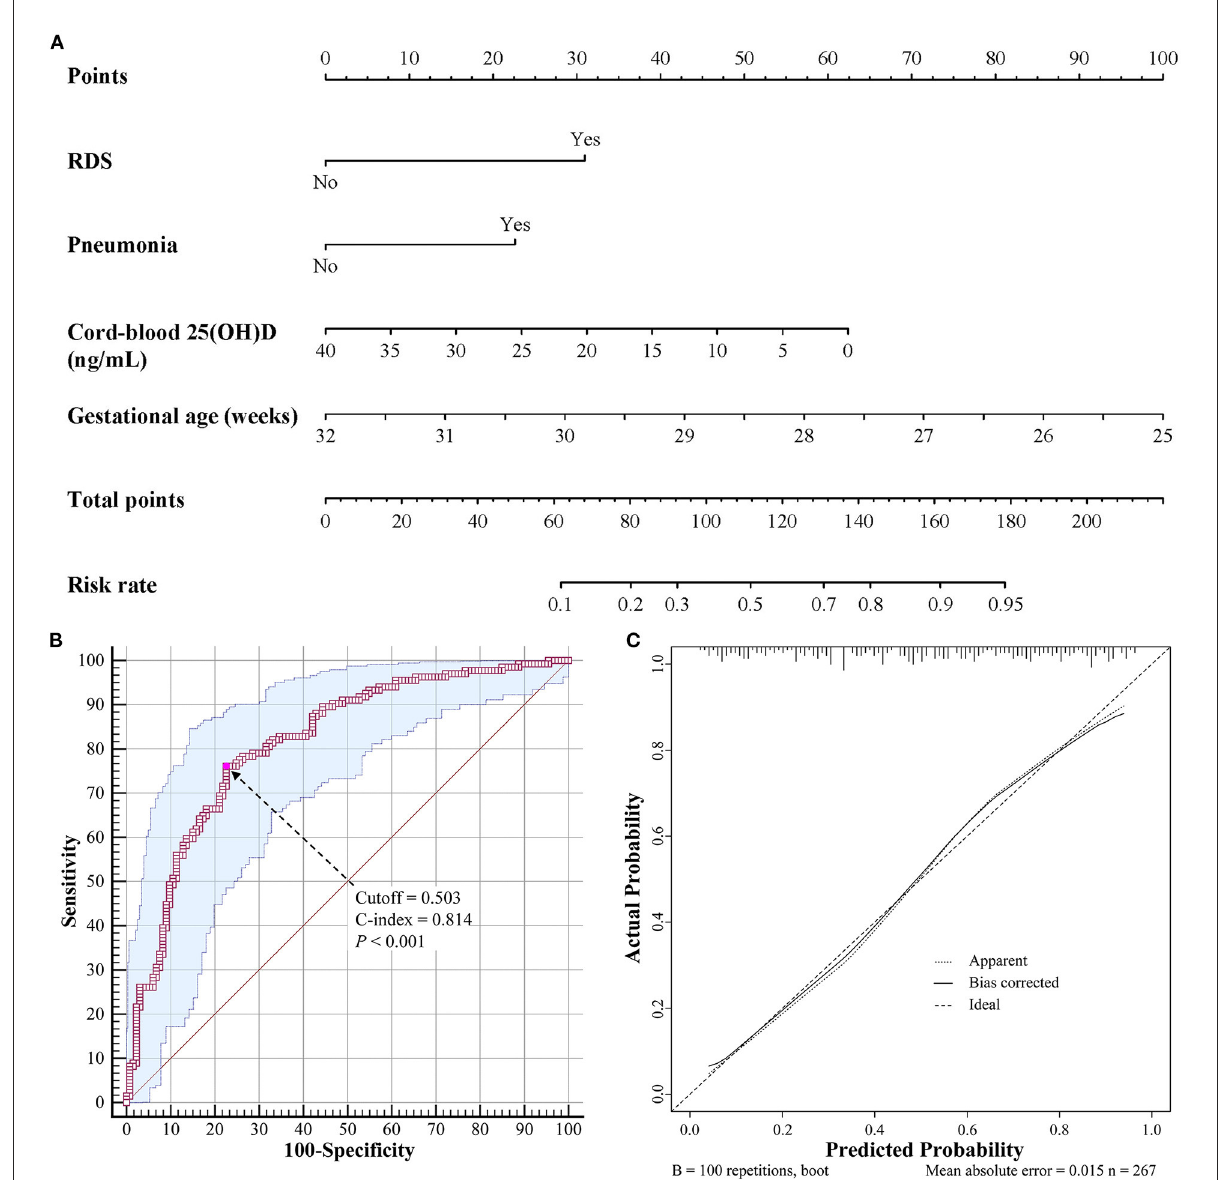
FIGURE1 Nomogram for predicting BPD in VLBW and ELBW preterm infants. (A) Nomogram model for prediction of BPD. (B) Receiver operating characteristic curve of the nomogram model. (C) Calibration curve of the nomogram model. BPD, bronchopulmonary dysplasia; VLBW, very low birth weight; ELBW, extremely low birth